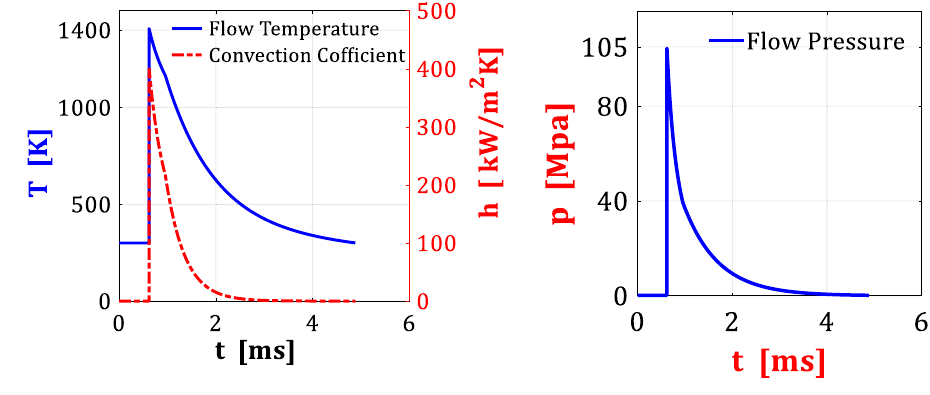
Fig. 9 Applied thermo- mechanical loads during the loading period at the inner surface of the thick-walled cylinder, 178 mm from the load source